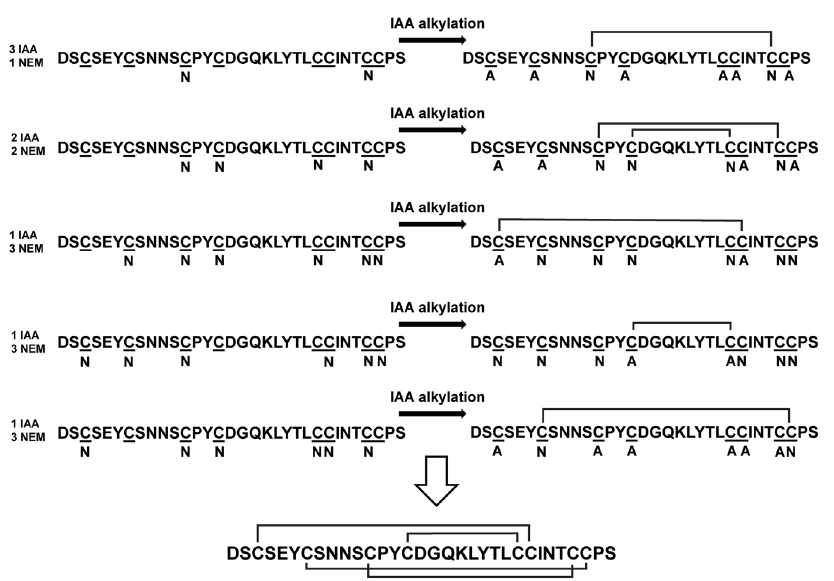
Figure 3. The disulfide structure was elucidated by S-tagged alkylation with iodoacetamide (IAA) and N-ethylmaleimide (NEM) of the peptide using a stepwise partial reduction alkylation strategy followed by MS/ MS analysis. N indicates cysteine residues alkylated with NEM and A indicates cysteine residues alkylated with IAA. Five partially reduced intermediates were alkylated with NEM followed by full reduction by dithiothreitol and S-alkylation with IAA. MS/MS-analysis of the differently S-alkylated peptides allows us to deduce the disulfide connectivity of